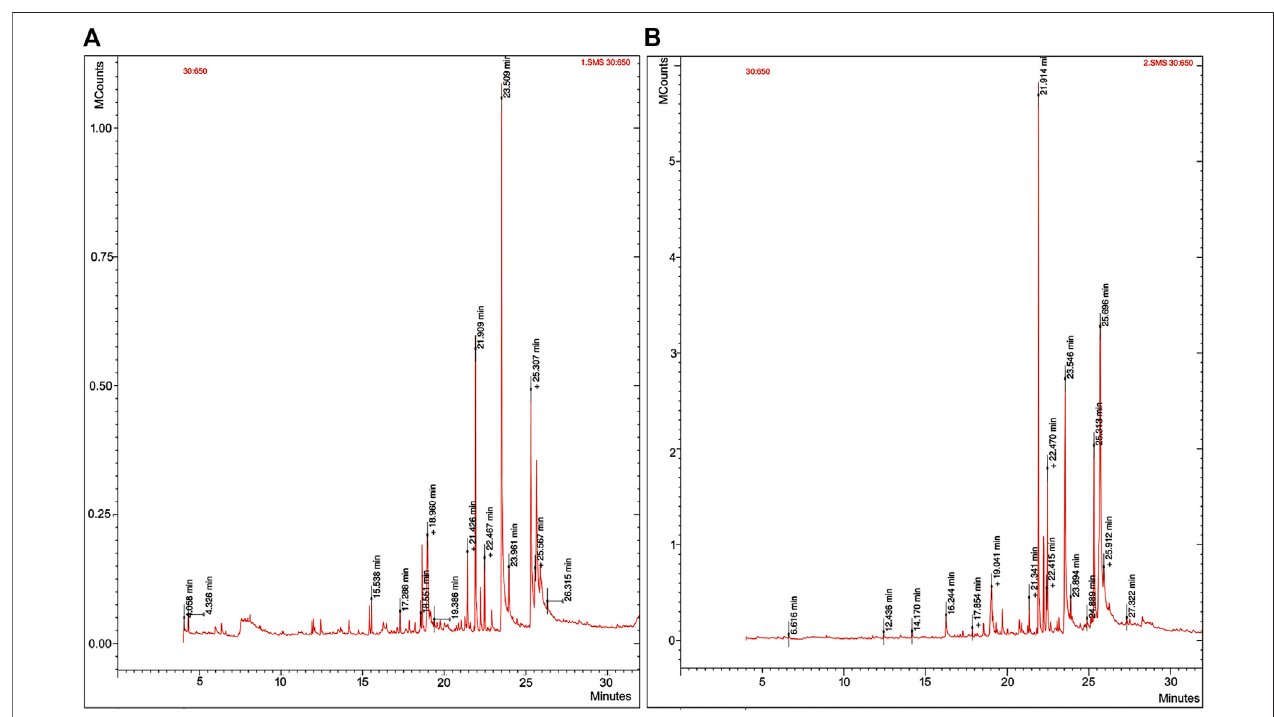
FIGURE1| Gaschromatography-mass spectrometry (GC-MS) of Swertiachirayita leaf extracts. (A) Ethanol extract of S. chirayita leaves and (B) methanol extract of S. chirayita leaves.